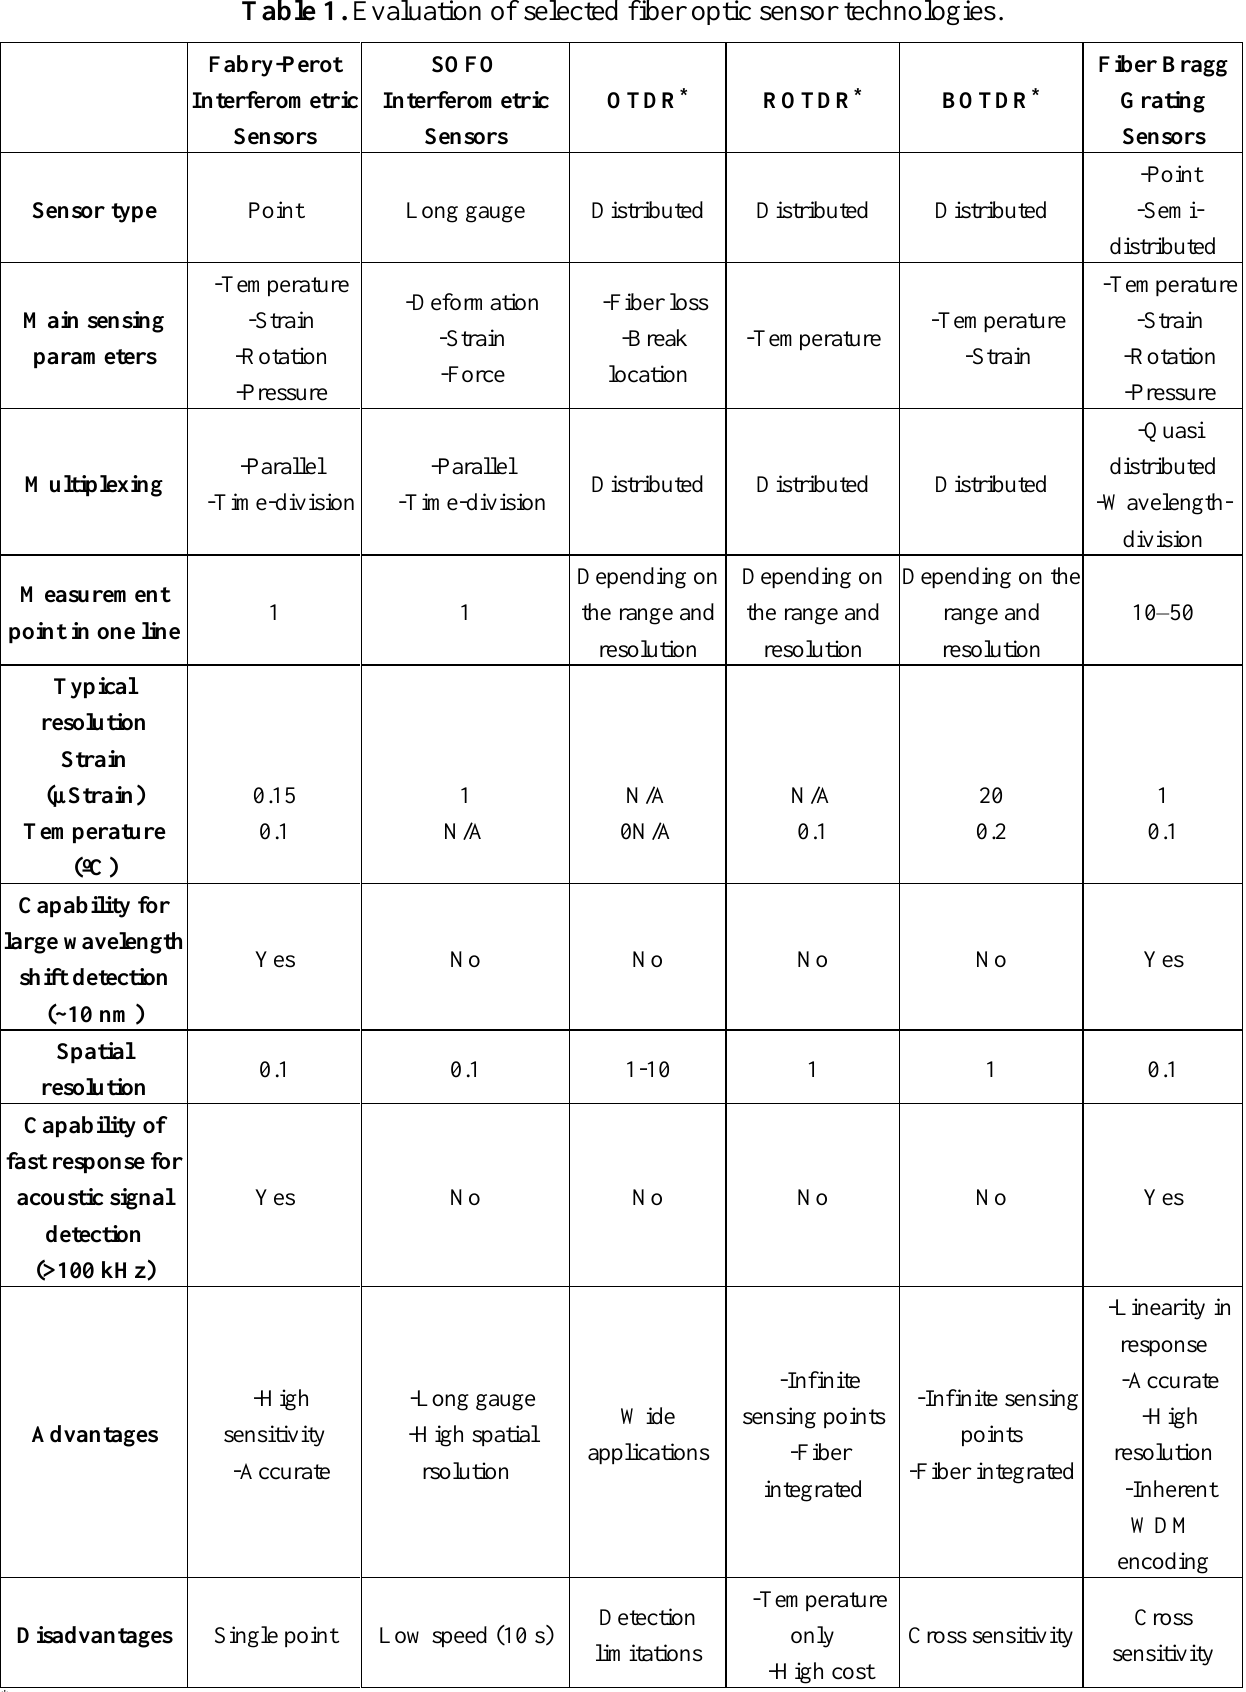
Table 1. Evaluation of selected fiber optic sensor